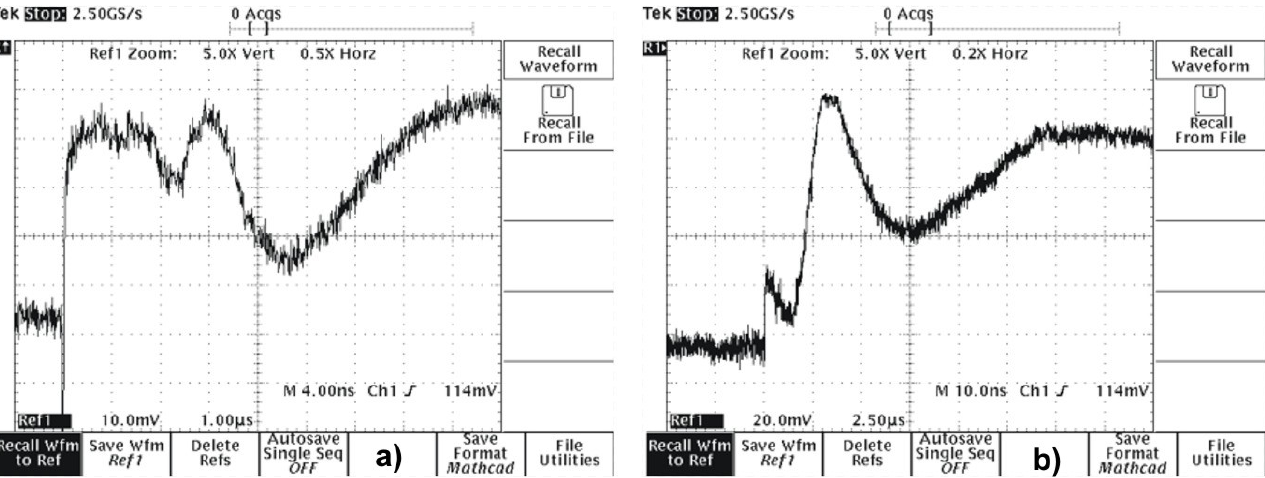
Figure 21. Photographs of different stone samples with dimensions of 4x20x20 mm 3 .